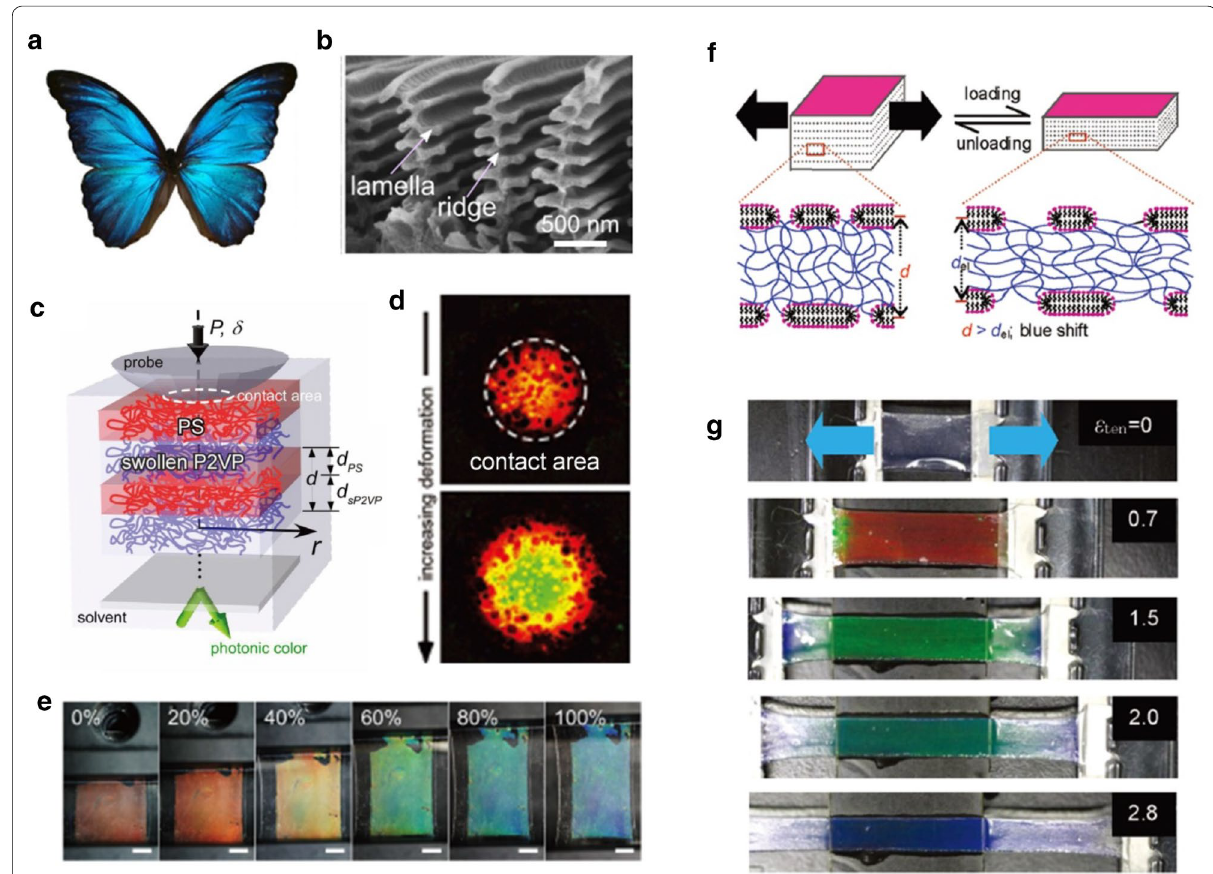
Fig. 7 1D Photonic crystals for mechanochromic applications a Structural color from morpho butterfly wings. b Morpho ridges and lamella structures with alternating layers of air and natural material. c 1D photonic crystals with a PS‑ b ‑P2VP block copolymer. d Mechanochromic